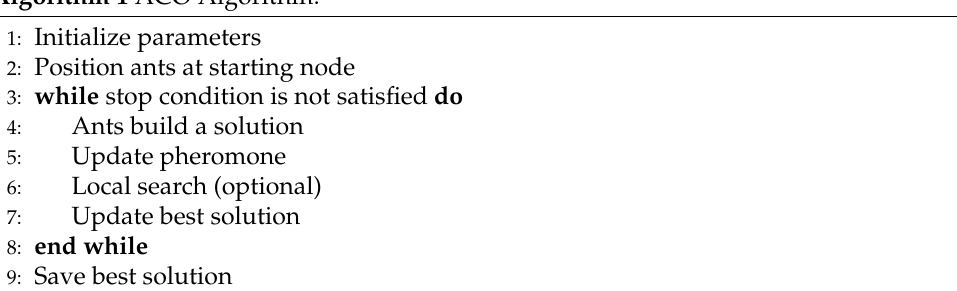
Algorithm 1 ACO Algorithm.